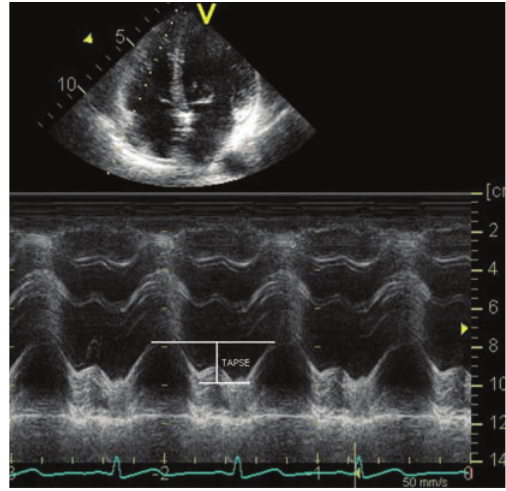
Figure 2: Tricuspid annular plane systolic excursion (TAPSE) for evaluating right ventricular contractility.